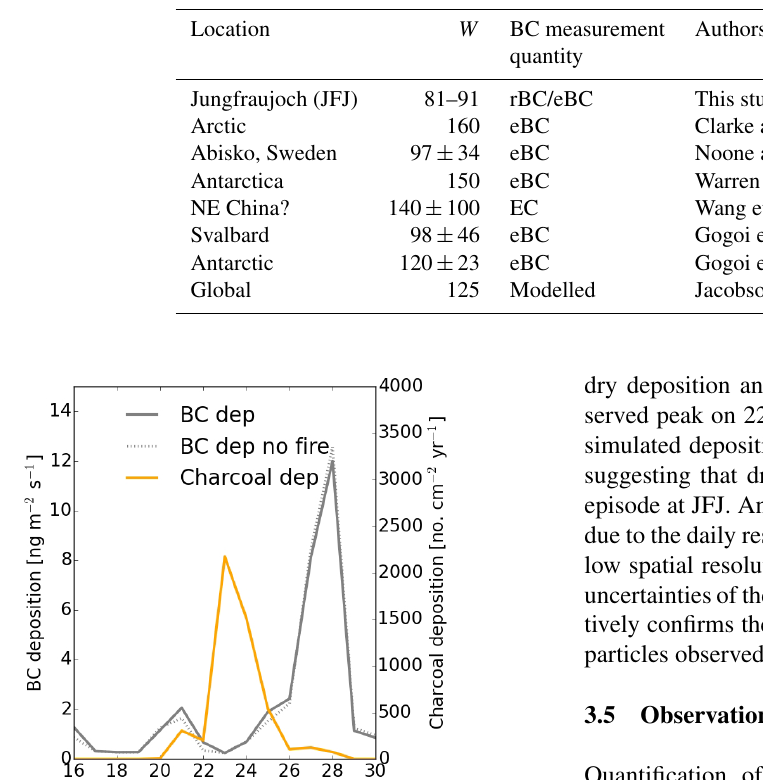
Table 2. Examples of BC scavenging ratios available in the literature.